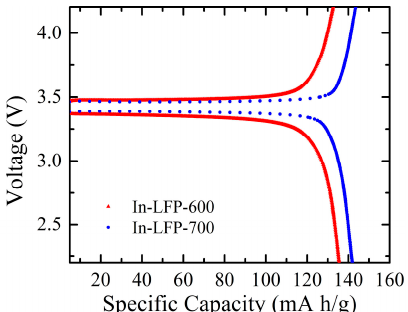
Figure 5. Charge/discharge profiles of In-LFP-600 and In-LFP-700 samples measured at 1 C rate.